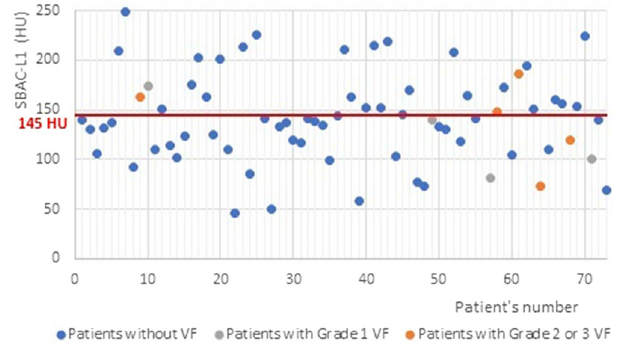
Figure 3. SBAC-L1 according the presence of